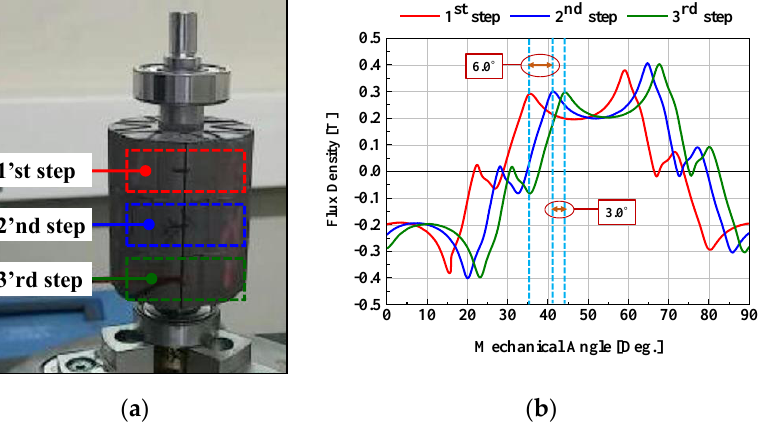
Figure 9. Measurement of the step-skew angle for the rotor-skew prototype: ( a ) rotor-skew prototype; ( b ) measurement of step skew angle.